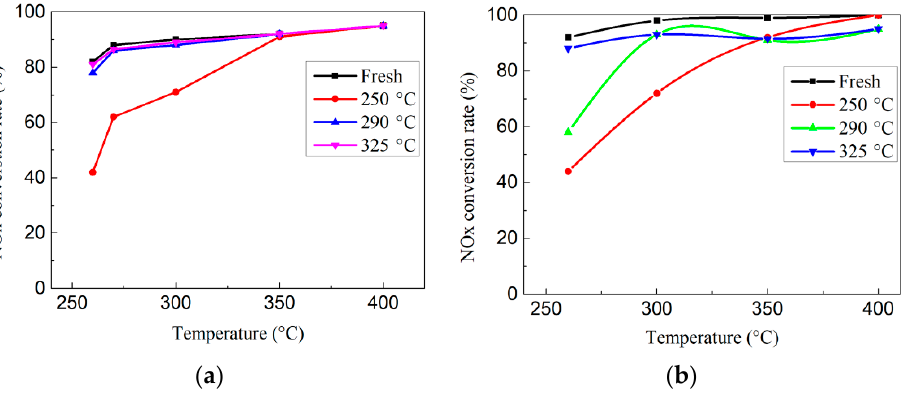
Figure 13. NOx conversion rate of the aged catalyst; ( a ) with non-injection urea, ( b ) with injection